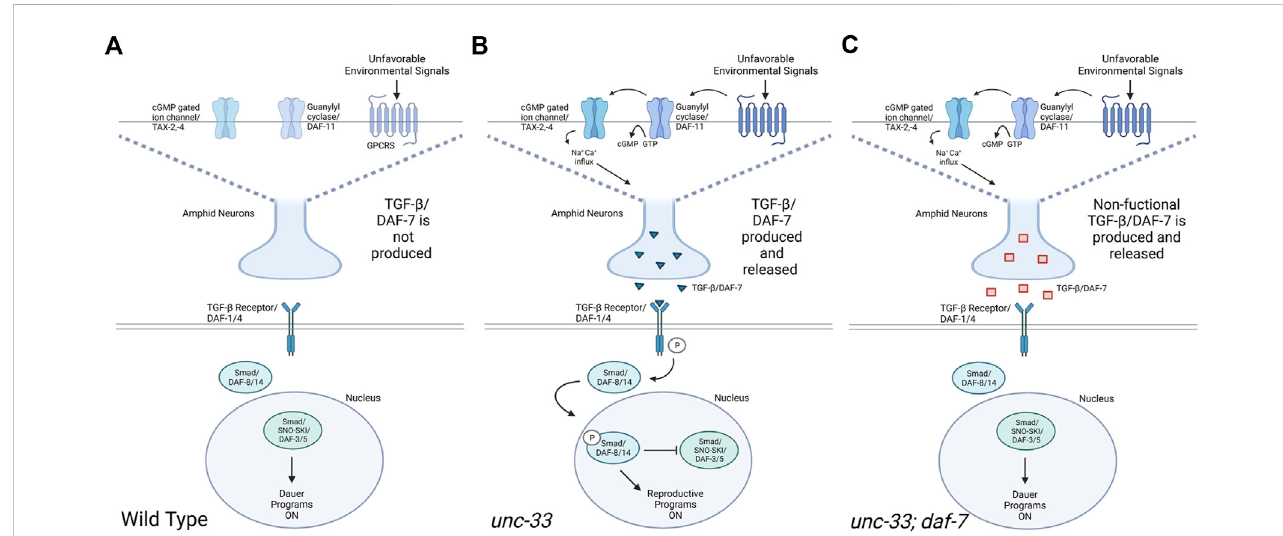
FIGURE 5 TGF β /DAF-7-dependent regulation of dauer formation under unfavorable environmental conditions. Schematic models depicting proposed molecular pathwaysregulatingdauerformationinwildtype, unc-33 mutants,and unc-33;daf-7 doublemutantsexposedtounfavorableenvironmentalconditions. (A) When unfavorable environmental signals are detected by wildtype animals, GPCRs are not activated, the production TGF β /DAF-7 is inhibited, and Smad/DAF-8/14 is unable to translocate into the nucleus. In the absence of nuclear DAF-8/14, Smad/SNO-SKI/DAF-3/5 inhibits the biosynthesis of hormones and promotes dauer formation. (B) Whenunfavorableenvironmentalsignalsare detectedby unc-33 mutants,GPCRsremain activeinducingthesynthesis ofcGMP. High levels ofcGMPopencGMPgated ion channels TAX-2,-4 depolarizing amphid neurons which release TGF β /DAF-7. The ligand TGF β /DAF-7 binds to the TGF β receptor which phosphorylates Smad/DAF-8/14. Phosphorylated Smad/DAF-8/14 translocates into the nucleus and inhibits Smad/SNO-SKI/DAF-3/5 which promotes reproductiveprogramstoremainactive. (C) Similarly,to unc-33 mutants , when unc-33;daf-7 doublemutantsareexposedtounfavorableenvironmentalsignals, GPCRsremainactiveleadingtothereleaseofthemutantTGF β /DAF-7.However,themutantTGF β /DAF-7doesnotbindtotheTGF β receptor,Smad/DAF-8/14is not phosphorylated rendering Smad/SNO-SKI/DAF-3/5 active, and dauer formation programs ON. Diagram created with